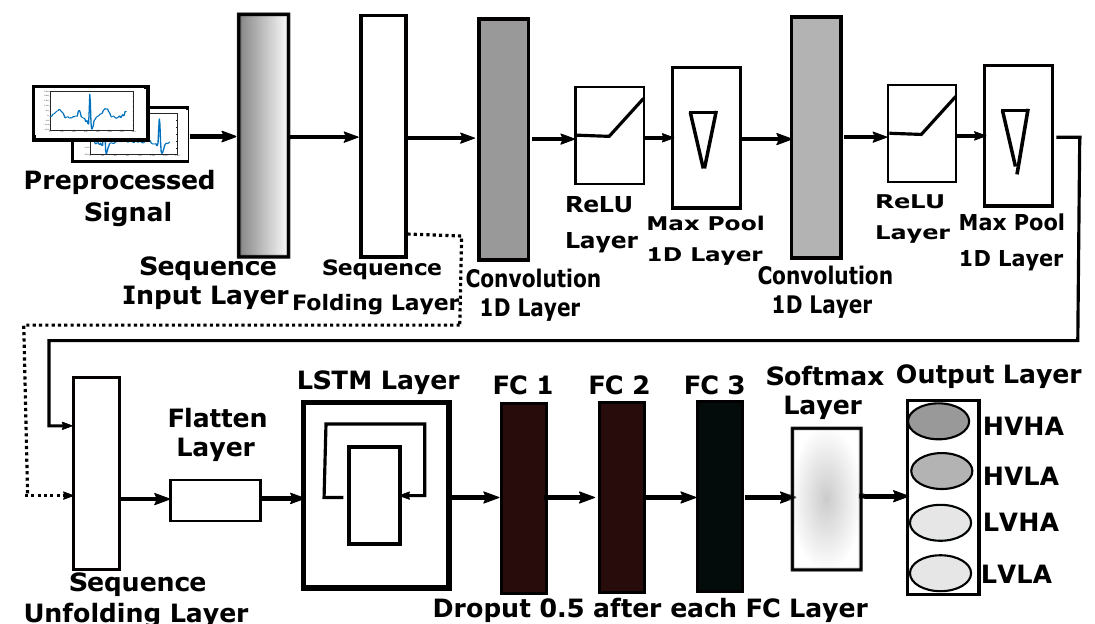
Figure 7. Design of deep neural network (1D-CNN + LSTM) for ECG and GSR-based sequence